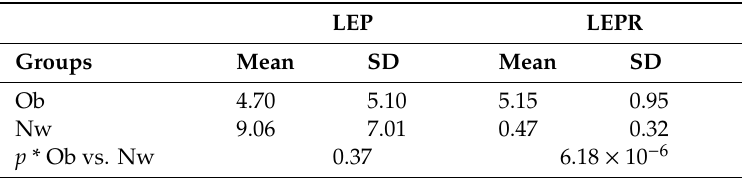
Table 6. Mean mRNA levels and standard deviation values (SD) of LEP and its receptor in Obese and Normal-weightskin dog. LEP LEPR Groups Mean SD Mean SD Ob 4.70 5.10 5.15 0.95 Nw 9.06 7.01 0.47 0.32 p * Ob vs. Nw 0.37 6.18 × 10 −